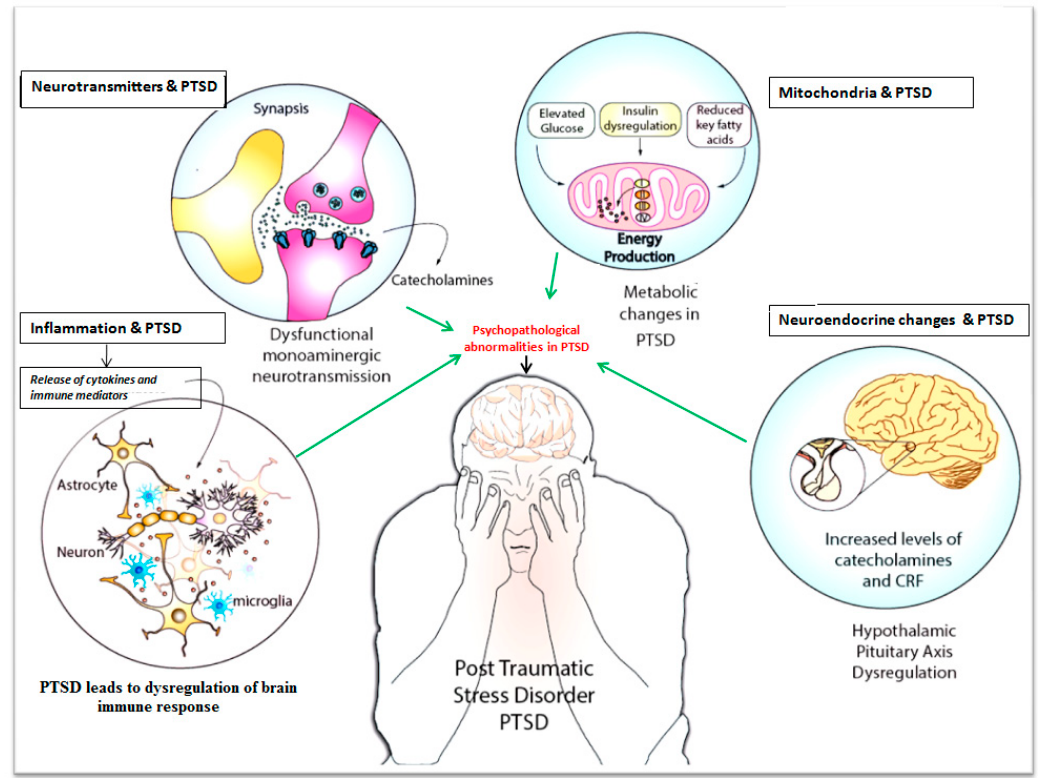
Figure 1. Systemic changes correlated to psychopathological changes during post-traumatic stress disorder (PTSD): PTSD may be associated with multifactorial disorders in the human body. A dysregulation of the immune system fosters neurophysiological and psychopathological changes due to elevated pro-inflammatory mediators such as IL-6 and IL-17. Impaired balance in the catecholamine neurotransmitter levels (e.g., monoaminergic neurotransmitters) across the synaptic junction confers psychopathological changes in PTSD. Metabolic alterations and mitochondrial dysfunction in neurons foster the psychopathological andneurophysiological changes during PTSD. Balanced release of secretions through hypothalamus-pituitary-adrenal (HPA)-axis signaling is crucial for ameliorating the PTSD effects since HPA-axis dysregulation causes inflammation, insulin resistance, oxidative stress, and energy deficiency due to the increased levels of catecholamines and corticothropin release factor.